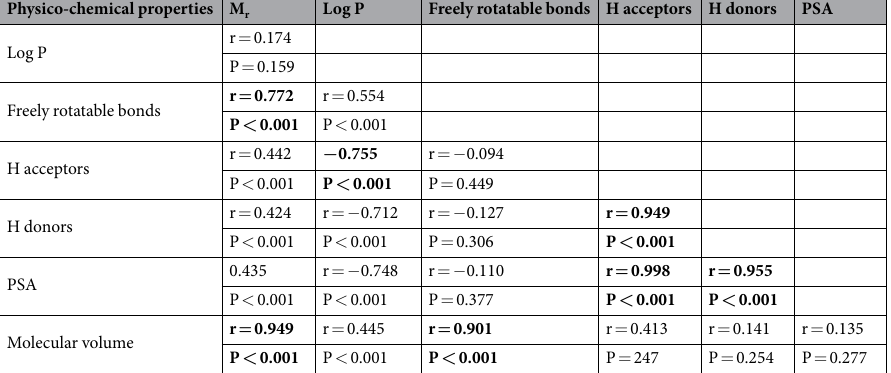
Table 1. Pearson correlations between physicochemical properties of phytochemicals in the training dataset (N = 67). Data reported as Pearson’s correlation coefficient (r) with P-values. Significantly high correlations (|r| > 0.75, P < 0.05) are highlighted with